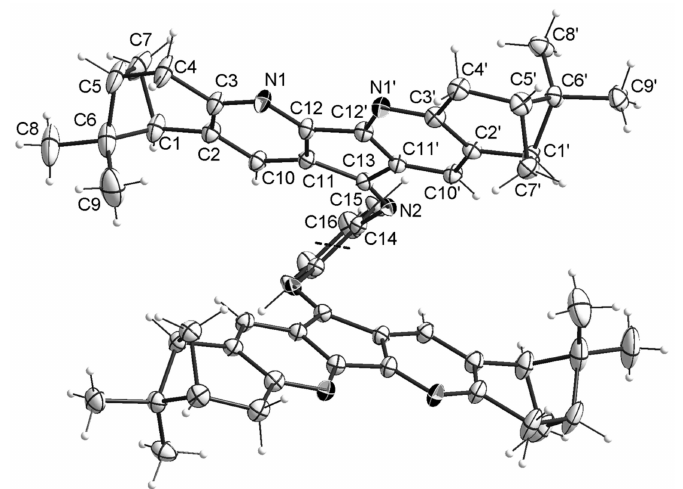
Figure 4. Crystal structure for compound 6 (the solvent molecules are not shown). C 2 axis is shown with black dashes.